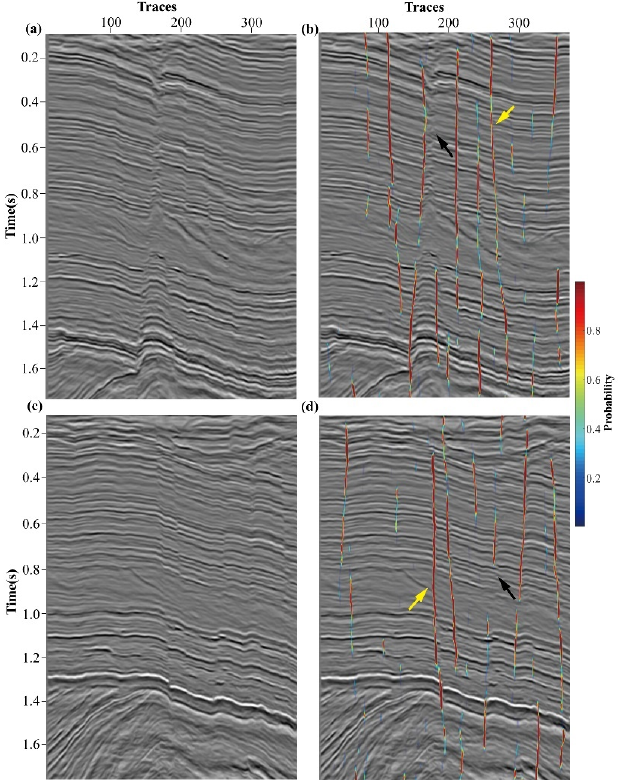
Figure 7. Fault detection test on Kerry3D sections: ( a ) and ( c ) two sections from Kerry 3D; and ( b ) and ( d ) the corresponding prediction results.